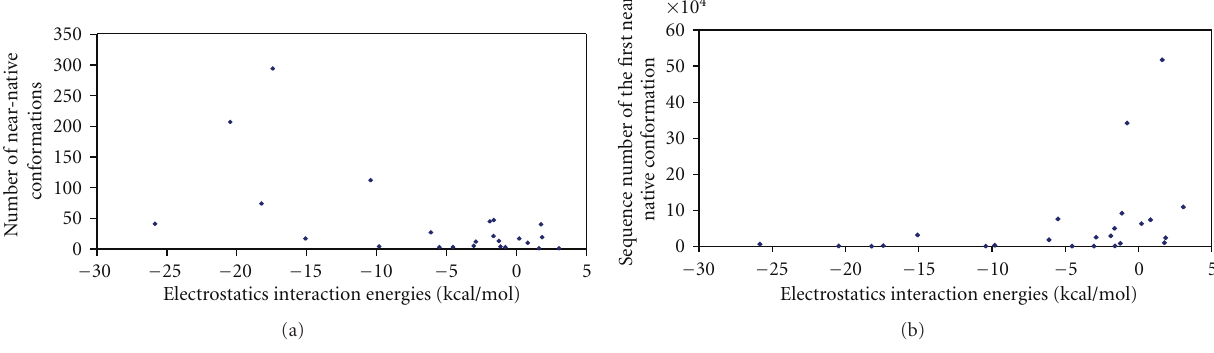
Figure 8: (a) Number of predicted near-native conformations versus electrostatics interaction energies within the test set. Conformations of which C α RMSDs < 5 ˚A compared to the crystal structure are regarded as predicted near-native conformations. (b) Sequence number of the first produced near-native conformations versus electrostatics interaction energies within the test